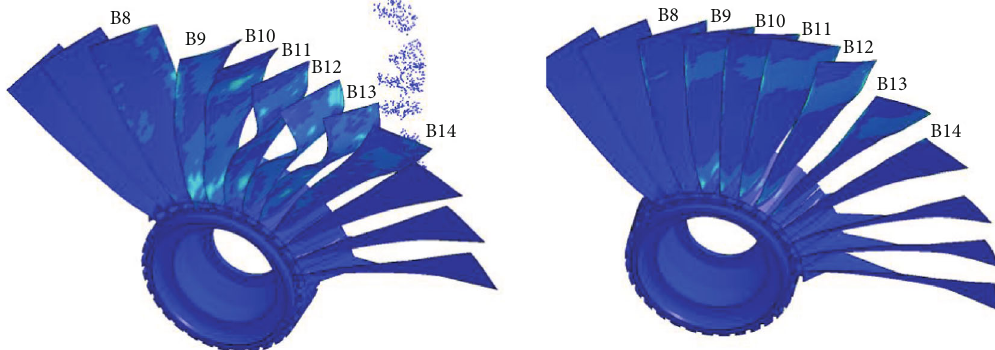
Figure 8: Bird slice and stress/strain status due to